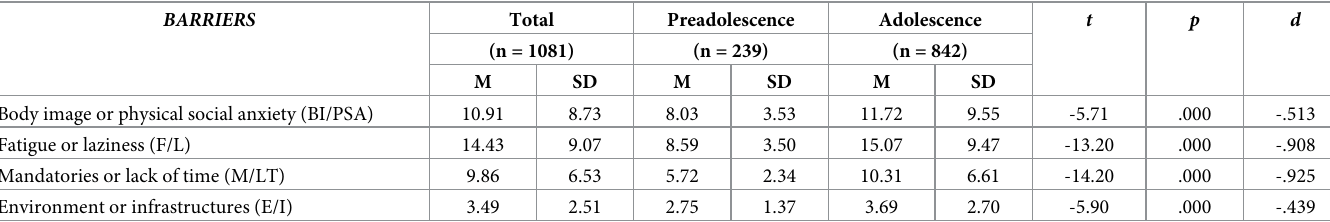
Table 2. Descriptive analysis and differences between preadolescents and adolescents in barriers towards the practice of physical exercise. BARRIERS